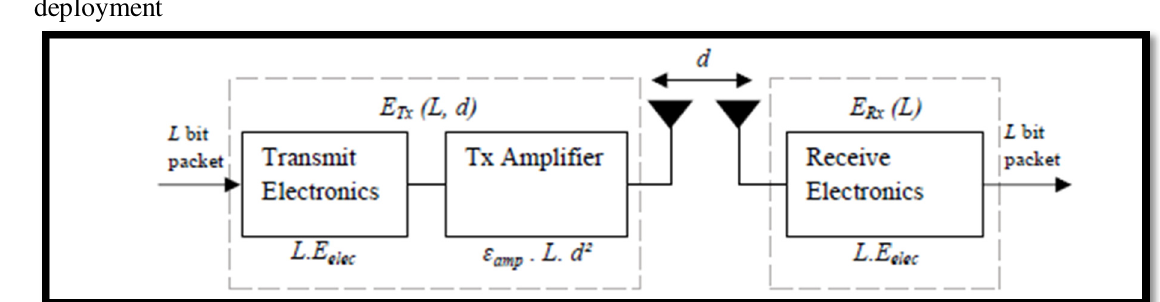
Fig. 4. First order energy